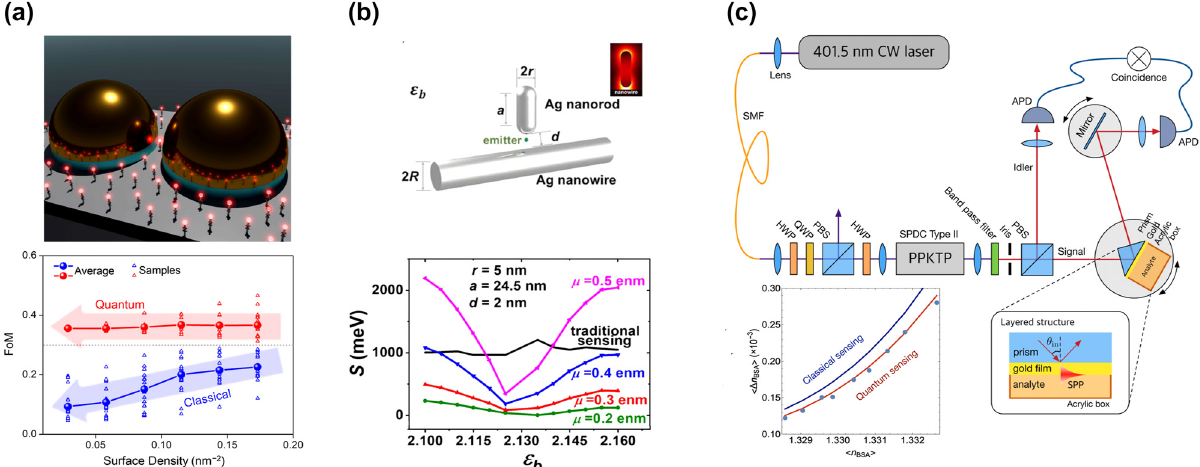
Figure 5: Plexcitonic and quantum-enhanced biomolecular sensors. (a) Strong coupling–assisted immunoassay sensing comprises a plasmonic dimer nanoantenna, an antigen, a sensing label, and two antibodies. The panel below illustrates the sensitivity figure-of-merit as a function of molecule density in the hotspot. (b) Theoretical demonstration of Ag nanorod–Ag nanowire sensing performance in the strong coupling regime. The panel below shows the sensitivity of such a nanocavity biosensor with a 2 nm gap size as a function of the emitter permittivity and transition dipole moment. The black curve corresponds to traditional plasmon sensing. (c) Quantum-enhanced Kretschmann SPR sensor setup. The panel below depicts the reduction of the refractive index uncertainty measured in the quantum sensing configuration (heralded photons) compared to a classical SPR sensor. The pictures are reproduced with permission: (a) Ref. [175] © 2019 American chemical society. (b) Ref. [176] © 2020 IOP publishing ltd. (c) Ref. [181] © 2018 optical